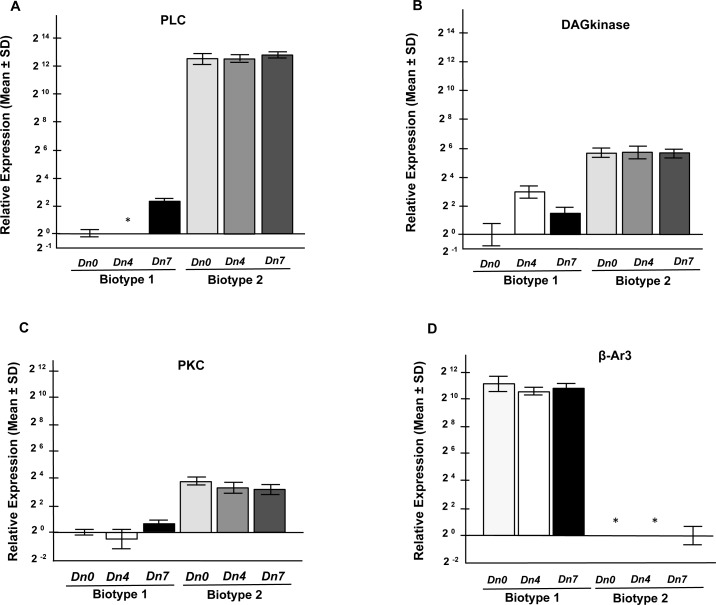
Relative expression (Mean ± SD) of (A) PLCγ1, (B) DAG kinase, (C) PKC, and (D) β-Ar3 in D. noxia biotype 1 and 2 aphids fed wheat plants containing the susceptible Dn0 gene, the biotype 1 resistant, biotype 2 susceptible Dn4 gene, or the biotype 1 and 2 resistant Dn7 gene.Expression of PLCγ1, DAG kinase, and PKC calculated relative to expression of each gene in biotype 1 aphids fed Dn0 plants. Expression of β-Ar3 calculated relative to expression in biotype 2 aphids fed Dn7 plants. Asterisk (*) denotes no observed amplification.